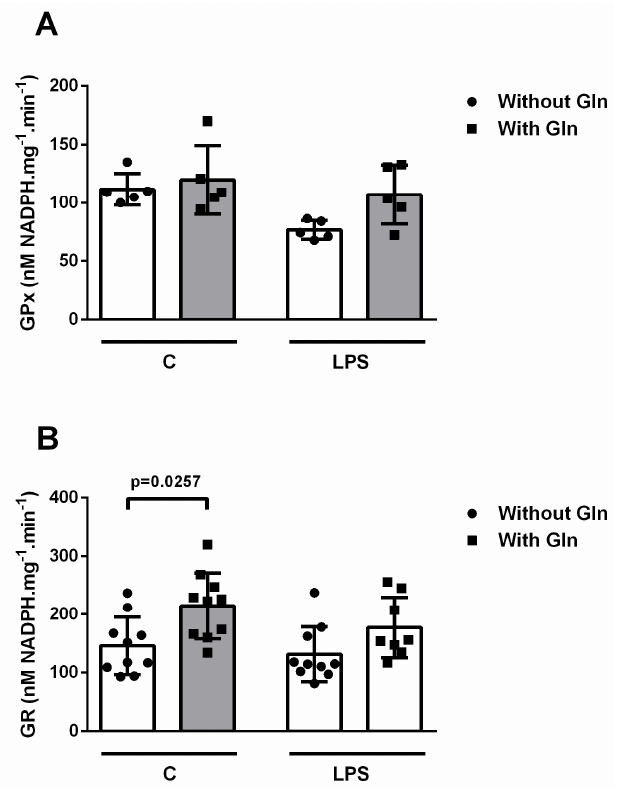
Figure 8. Glutathione reductase (GR) and glutathione peroxidase (GPx) activity in bronchoalveolar lavage fluid (BALF) cells. ( A ) GPx activity was measured indirectly by monitoring NADPH oxidation. One unit of GPx is equivalent to the oxidation of 1 µmol of NADPH per min at pH 7.0 and 37 °C. ( B ) GR activity was measured by monitoring β -NADPH oxidation. One unit of GR is equivalent to the oxidation of 1 µmol of β -NADPH per min at pH 7.0 and 30 °C. Values expressed as mean ± SD of five to 10 animals in each group. Symbols represent individual animals. Experiments were performed in triplicate. The data shown are from a single representative experiment.